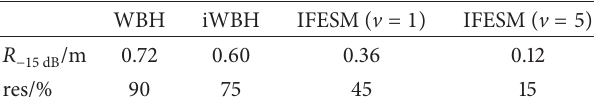
Table 1: Comparison of 𝑅 −15 dB and